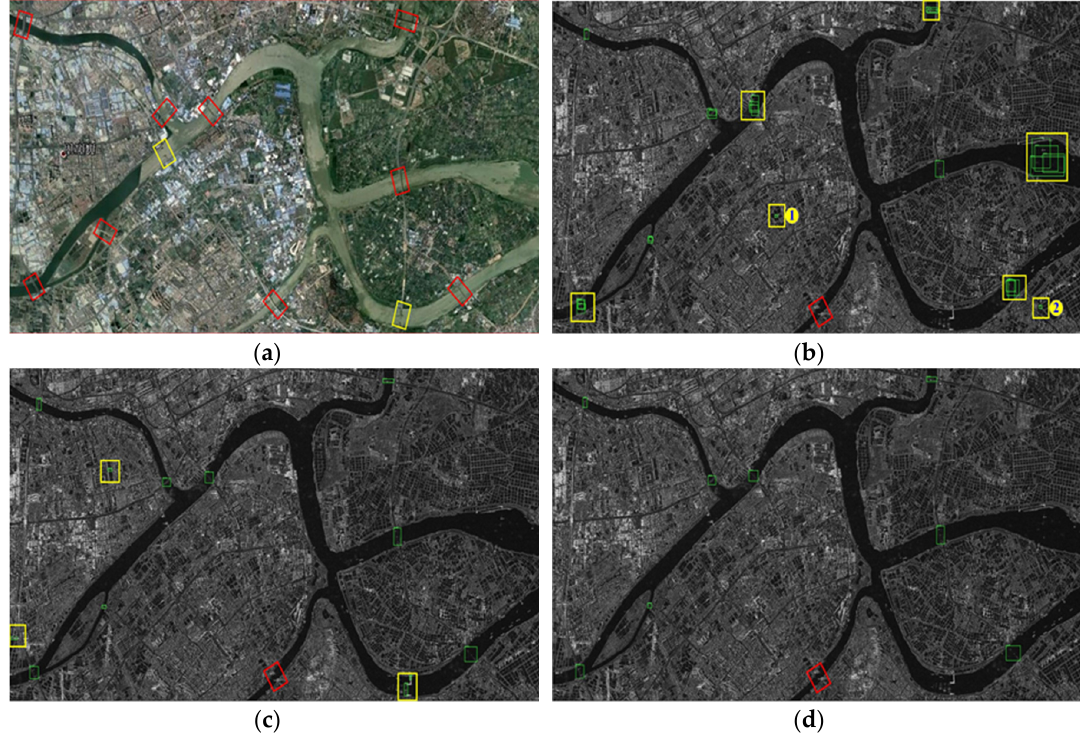
15 of 19 Figure 10. The corresponding optical image and detected results of bridges by different networks for Scene 1. ( a ) the corresponding optical image of Scene 1. ( b ) the detected result of bridges by Faster R-